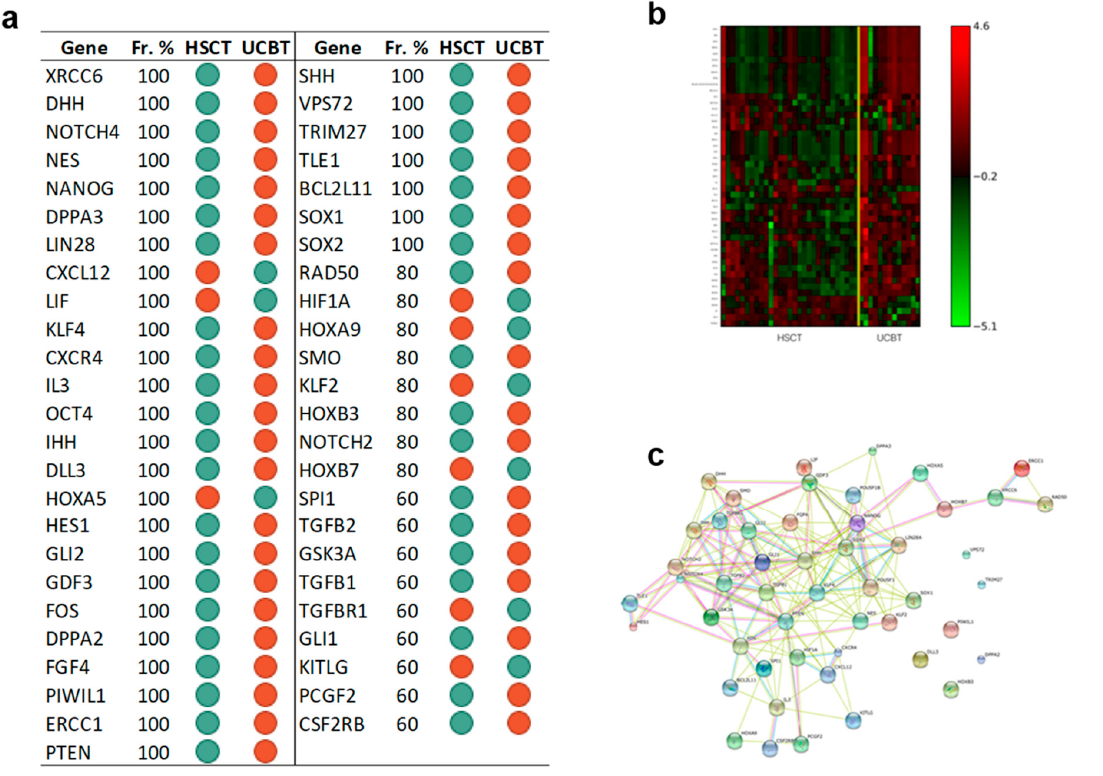
Figure 7. Data showed that CD34+ cells after transplantation acquire a divergent transcriptional asset based on the source of HSC: Adults HSPC or UCB. We found that genes involved in reprogramming and self-renewal are a relevant part of such difference. Furthermore, NOTCH and Hedgehog pathways were highlighted as relevant in KEGG analysis. Panel a : Gene Signature. List of 49 gene symbols selected by the l 1 l 2FS procedure [1,2] . For each gene we report, the corresponding frequency percentage score and the gene expression relative to the comparison between indicated groups: Green dots, downregulation; red dots, upregulation. Panel b : Heatmap associated with the 49 genes of the signature discriminating between adult after UCBT (13 samples) and adult and pediatric after HSCT (29 samples). The expression data for each gene has been scaled and is represented by pseudo-colors in the heatmap. Red color corresponds to a high level of expression and green color corresponds to a low level of expression as also shown in the color bar. Panel c : Association network of the genes in the signature between adult after UCBT (13 samples) and adult and pediatric after HSCT (29 samples) inferred by the STRING online tool. The identified connections are of five different types: Text mining (lime green), Experiments (magenta), Databases (Turquoise), Coexpression (Black), Homology (purple).